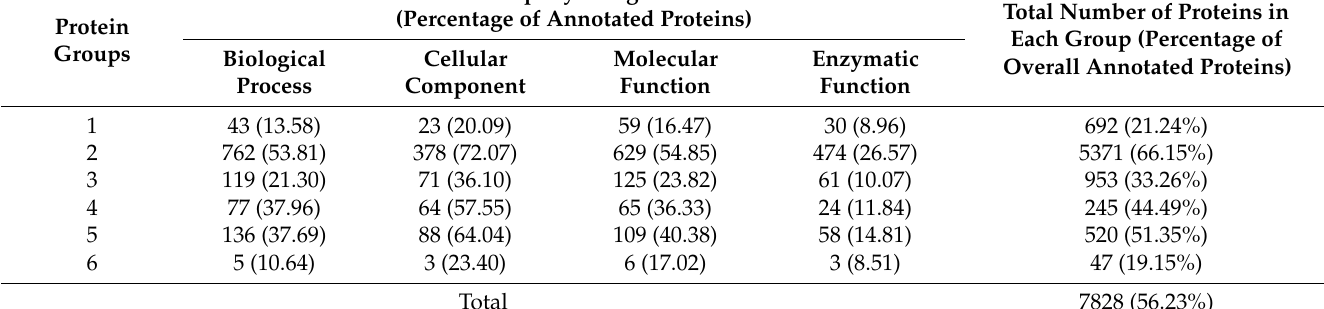
Table 2. Comparison of the number of uniquely assigned GO terms (biological process, cellular component, molecular function, and enzymatic function) to Leishmanial proteins and percentage of protein annotation in the six groups clustered according to the protein sequence similarity between the southern isolates of L. orientalis (PCM2) and L. martiniquensis (PCM3) and the northern ones (LSCM1 and LSCM4), as well as other Leishmania species.